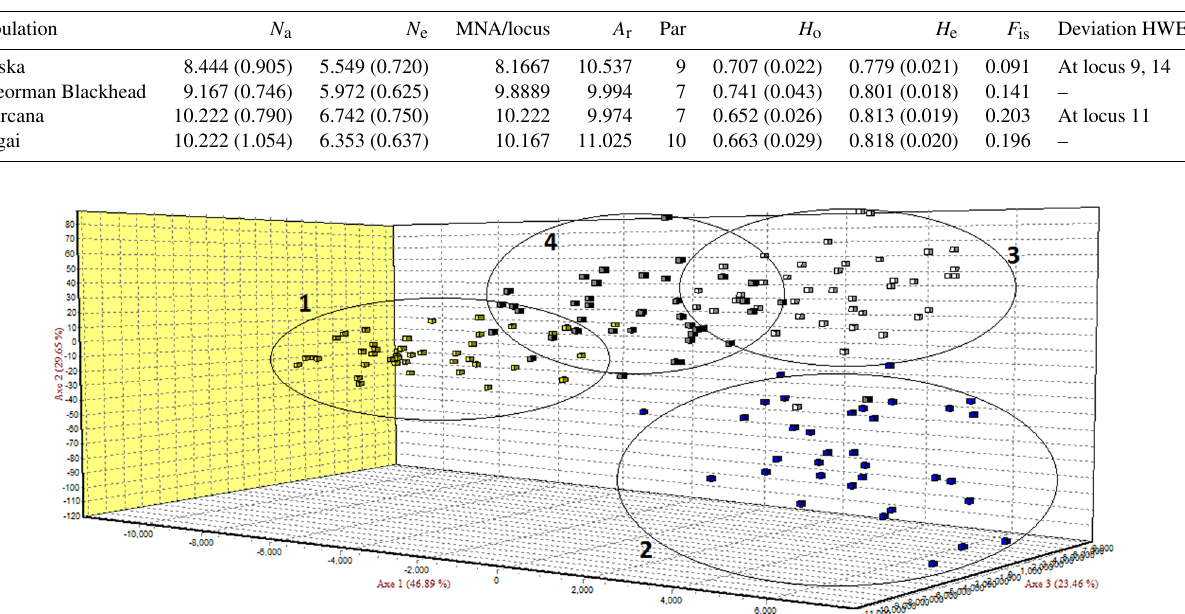
Table 2. Genetic variability for Romanian sheep breeds (standard error values are in the brackets). N a – number of different alleles; N e – number of effective alleles; MNA/locus – mean number of alleles per locus; A r – allelic richness; Par – private allelic richness; H o – observed heterozygosity; H e – expected heterozygosity; F is – F is values (averaged over all loci); Deviation HWE – deviations from Hardy–Weinberg equilibrium.